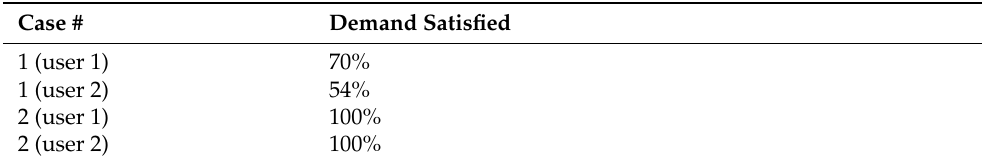
Figure 9. Actual demand satisfied to consumers subjected to curtailing (top) and shedding (middle and bottom) agreements in the studied cases. Table 9. Percentage of total demand satisfied to consumers subjected to energy agreements in the studied cases.